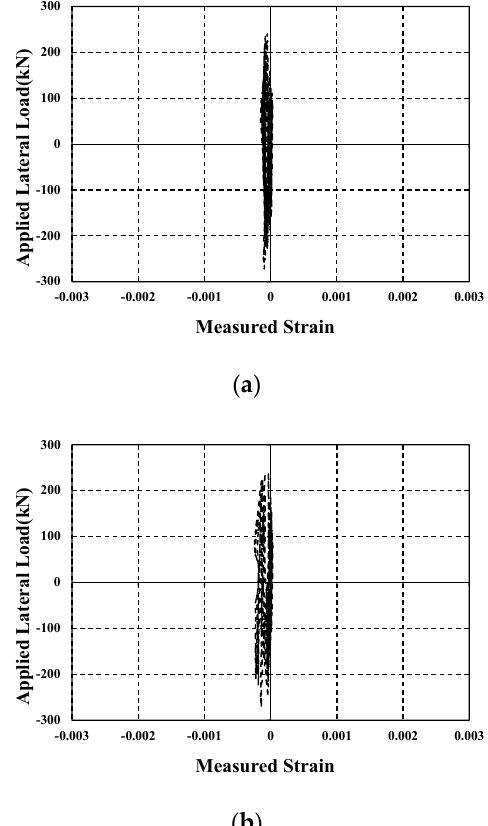
Figure 10. Lateral load-strain relationship of anchor bolts: ( a ) at beam (Specimen FBC) ( b ) at column (Specimen FBC).